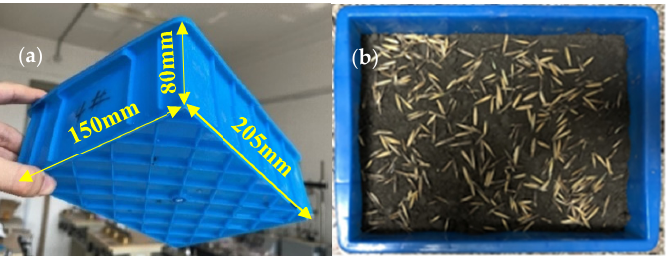
Figure 2. ( a ) Culture box; ( b ) oat sowing.